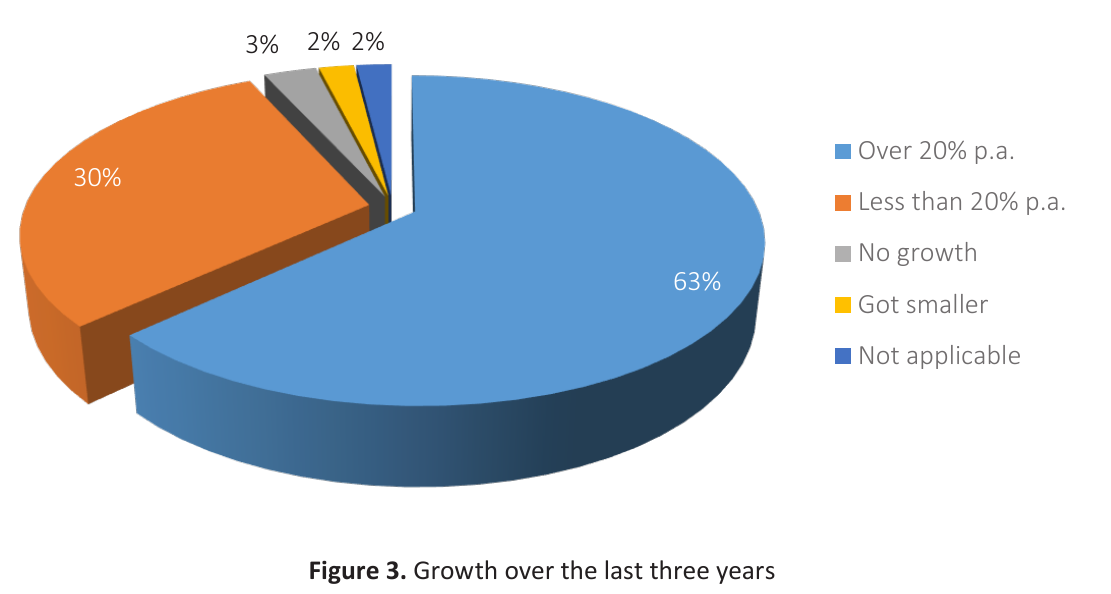
Figure 2. Future growth of firm